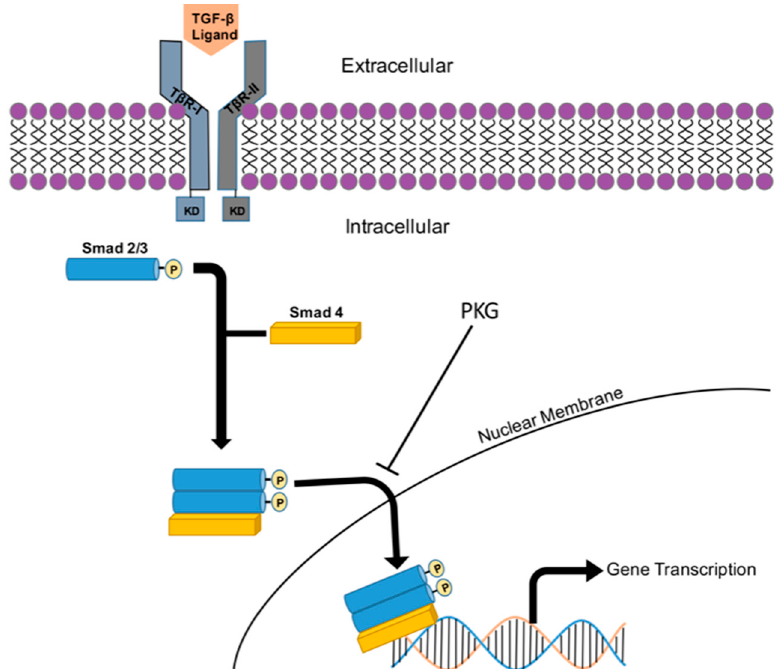
Figure 7. Schematic of transforming growth factor- β (TGF- β ) signaling. Binding of an active TGF- β ligand initiates the co-localization of the type II (T β R-II) and type I (T β R-I) TGF- β receptors. The T β R-II remains constitutively phosphorylated and when co-localized phosphorylates the Ser/Thr kinase domain (KD) of the T β R-I. The intracellular signal is subsequently transmitted by phosphorylation of Smad proteins, primarily Smad2/3 in cardiovascular tissues. The phosphorylated Smad proteins combine with Smad4, a common Smad, to form a heterotrimeric complex that can then be shuttled through the nuclear membrane ultimately acting as a transcription factor for inflammatory, synthetic, and growth-promoting genes. The cyclic GMP/PKG system is known to inhibit this pathway by sequestering p-Smad in the cytosol, in turn not allowing it to be shuttled into the nucleus and affect gene transcription.